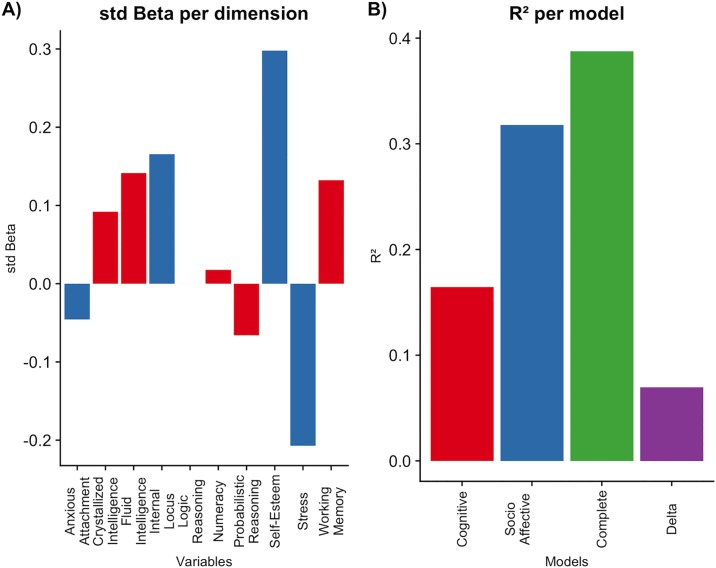
Contribution of each group to the dependent variable’s variance.A) Standardized beta values of each independent variable in predicting social adaptation B) R² values of the Cognitive and Socio-affective models; the complete model that includes the cognitive variables over the socio-affective variables; and the delta R², that shows the contribution of the cognitive model over the socio-affective model.